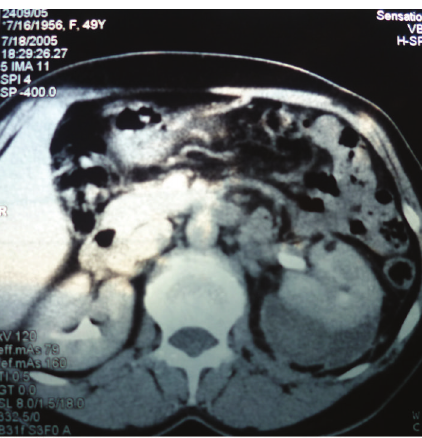
Figure 1: CT scan revealed a perirenal hematoma around the left kidney with an angiomyolipoma in the ventral part of the kidney.